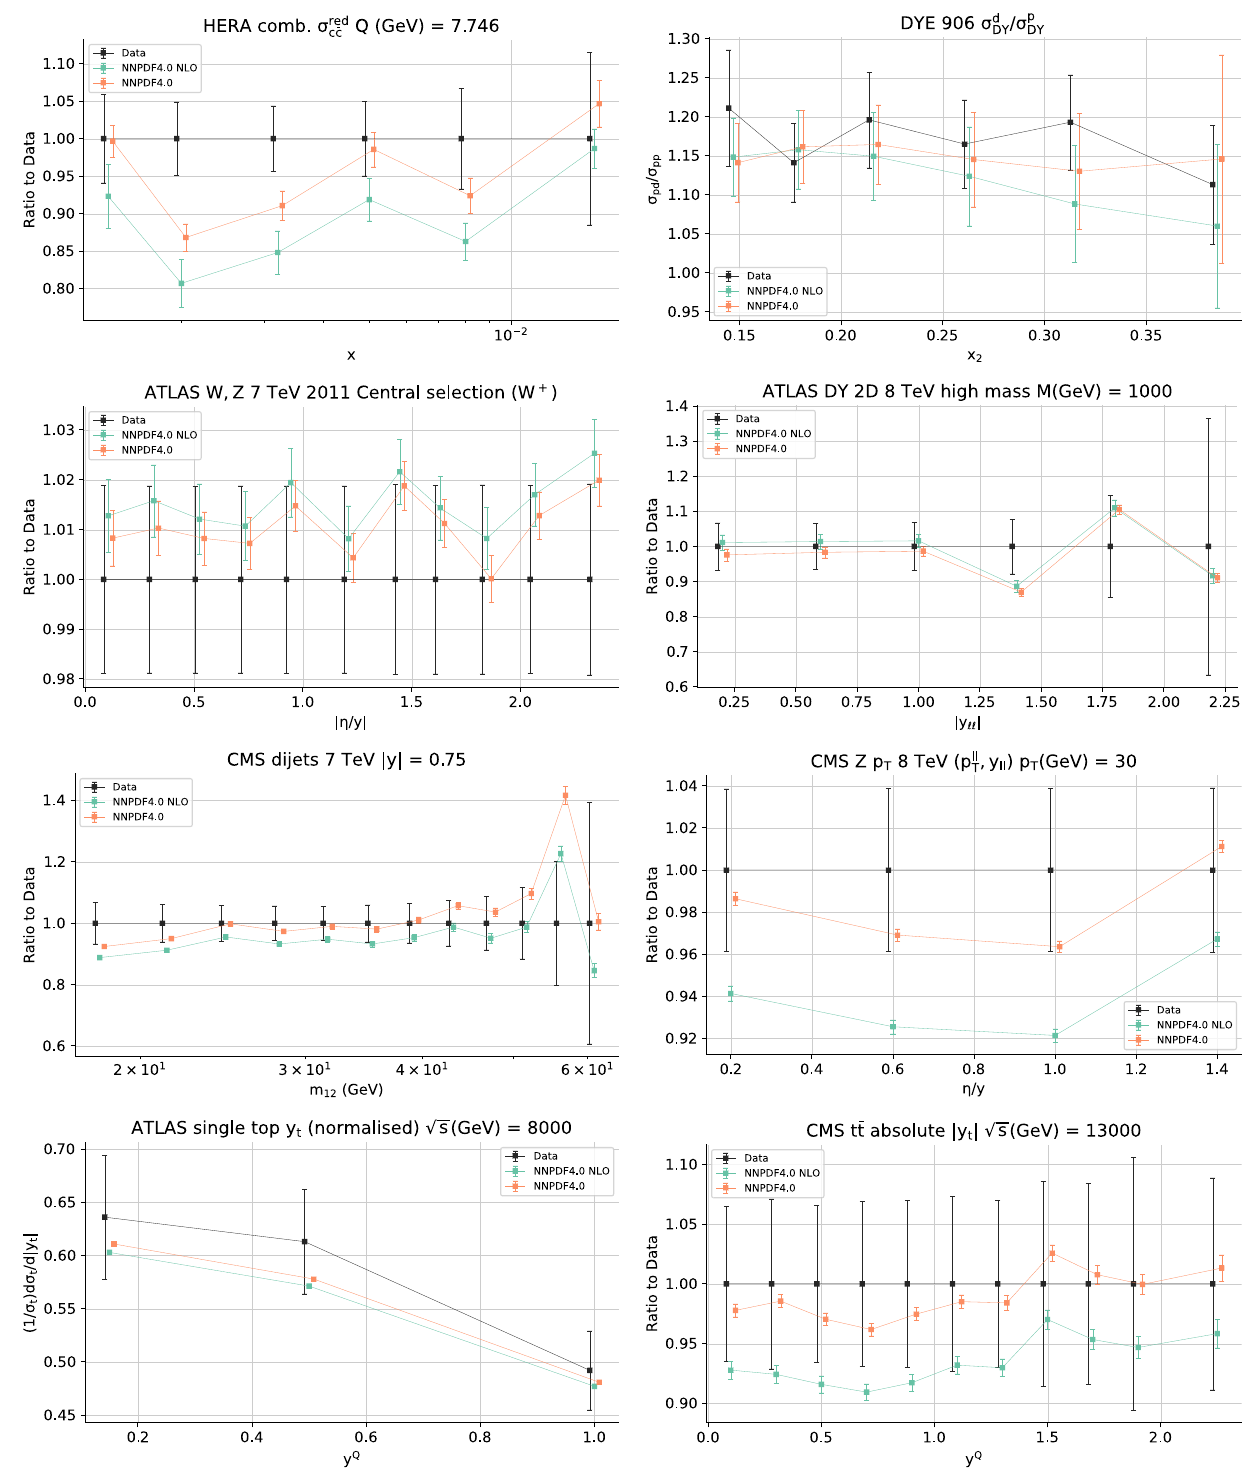
Fig. 23 Comparison between data points and NLO and NNLO best-fit results for a selection of fitted data points (see text). Results are gener- ally shown as ratios to the central experimental value, with one-sigma